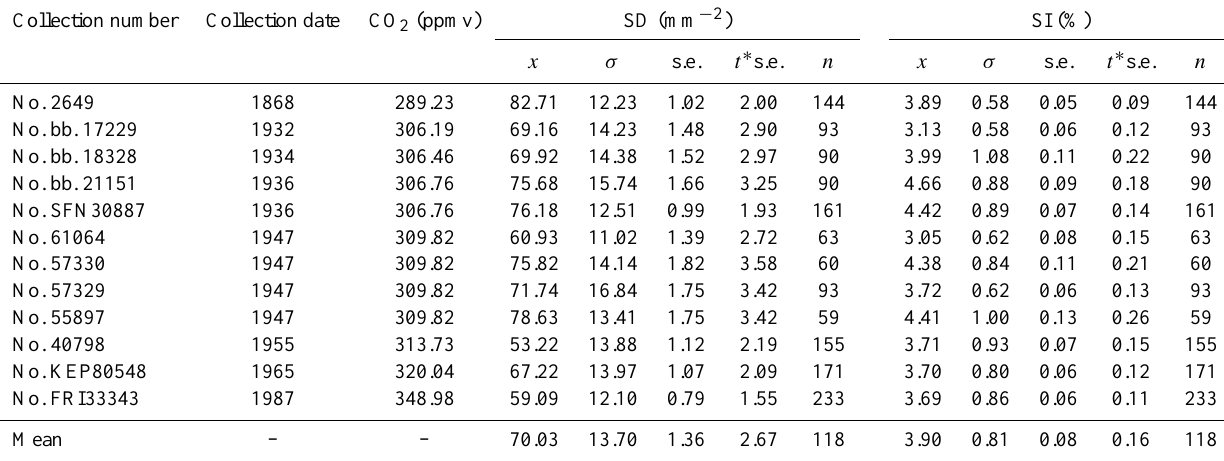
Table 3. Summary of stomatal parameters of the abaxial surface from modern Nageia motleyi (Parl.) De Laub. Collection